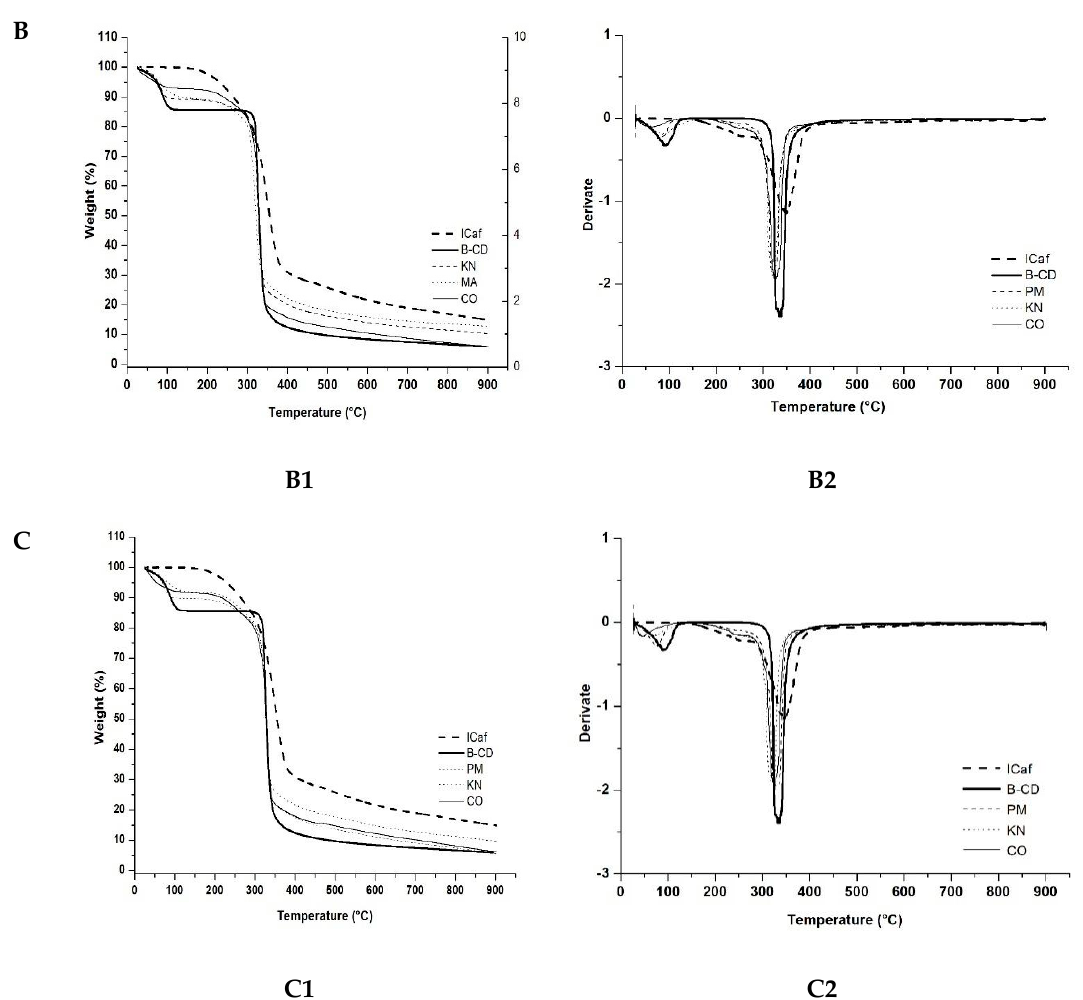
Figure 3. Thermogravimetric (A1, B1, C1) and derivative thermogravimetric (A2, B2, C2) analyses of isopentyl caffeate (ICaf), β -cyclodextrin β -CD, and inclusion complex prepared by physical mixture (PM), kneading (KN) and co-evaporation (CO) using molar ratios of (ICaf: β -CD) of ( A ) 0.25:1, ( B ) 1:1 and ( C ) 2:1. Table 2. Mass loss obtained by TG of isopentyl caffeate (ICaf), β -cyclodextrin ( β -CD), and inclusion complex prepared by physical mixture (PM), kneading (KN) and co-evaporation (CO) using